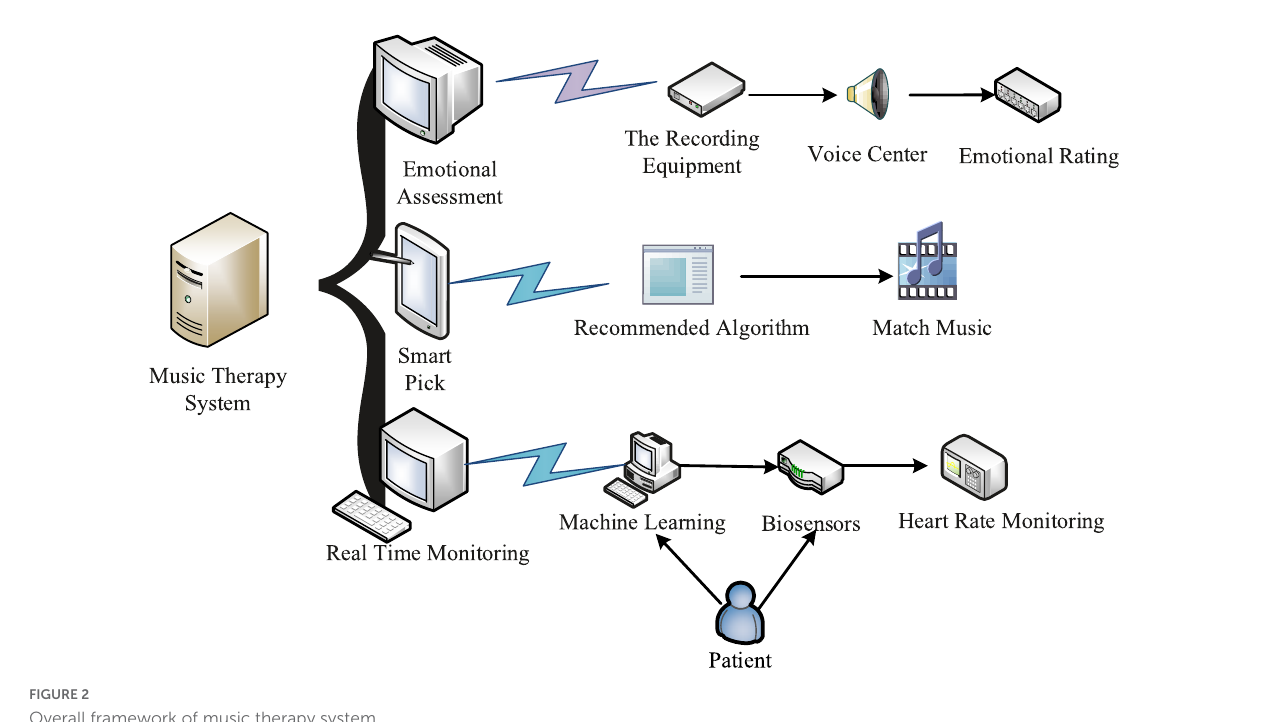
FIGURE2 Overall framework of music therapy system.